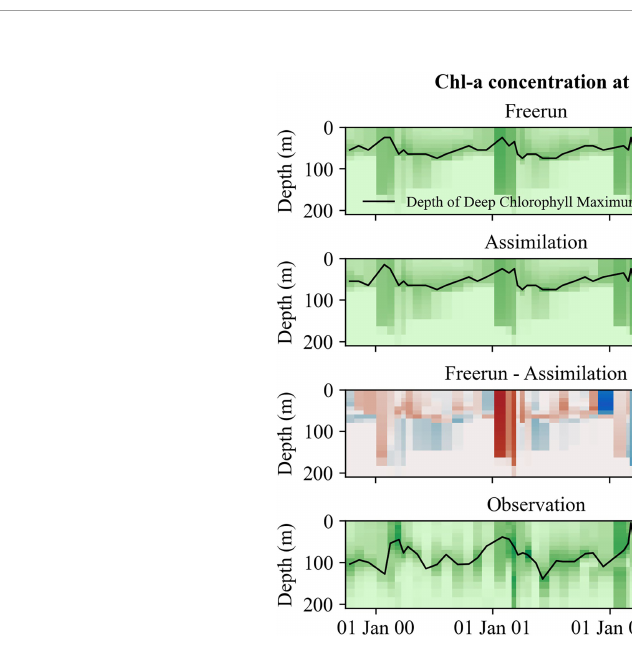
FIGURE 13 Simulations of chl-a concentration of EXP State_EP at BATS. The black solid lines represent